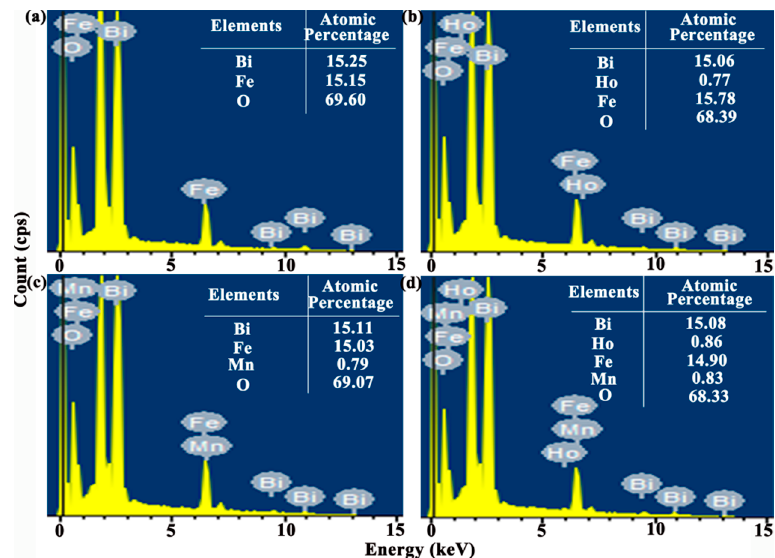
Figure 3. Energy dispersive spectroscopy (EDS) spectrum of ( a ) BFO ( b ) BHFO ( c ) BFMO ( d ) BHFMO thin film. Table 1. The content of metal elements in BiFeO 3 (BFO), Bi 0.95 Ho 0.05 FeO 3 (BHFO), BiFe 0.95 Mn 0.05 O 3